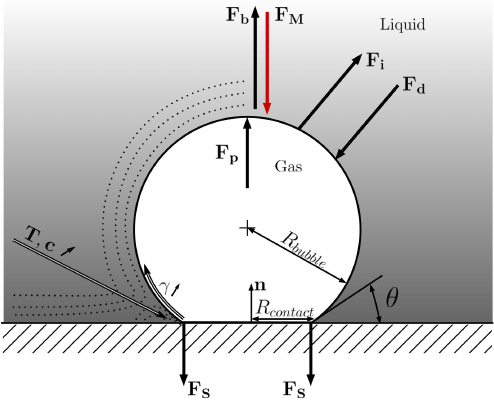
Figure 1. Balance of forces acting on a gas bubble attached to a horizontal